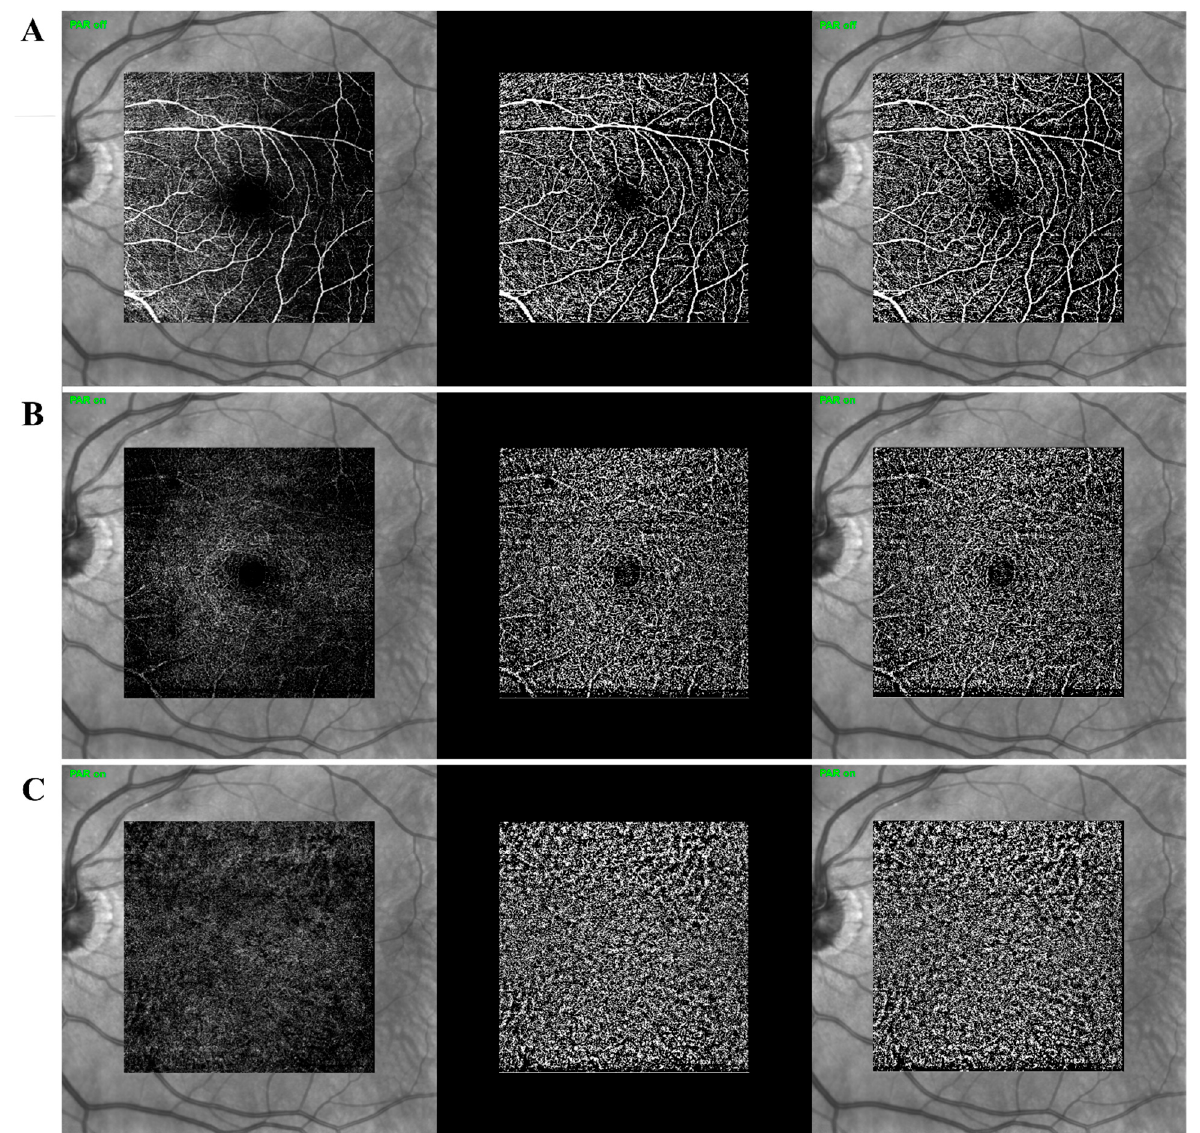
( C ) Image binarization—converting grey scale in binarized images. ( D ) Studied area and image soft- ware: Black pixels images (vascular lumen) and white pixels images (stroma).